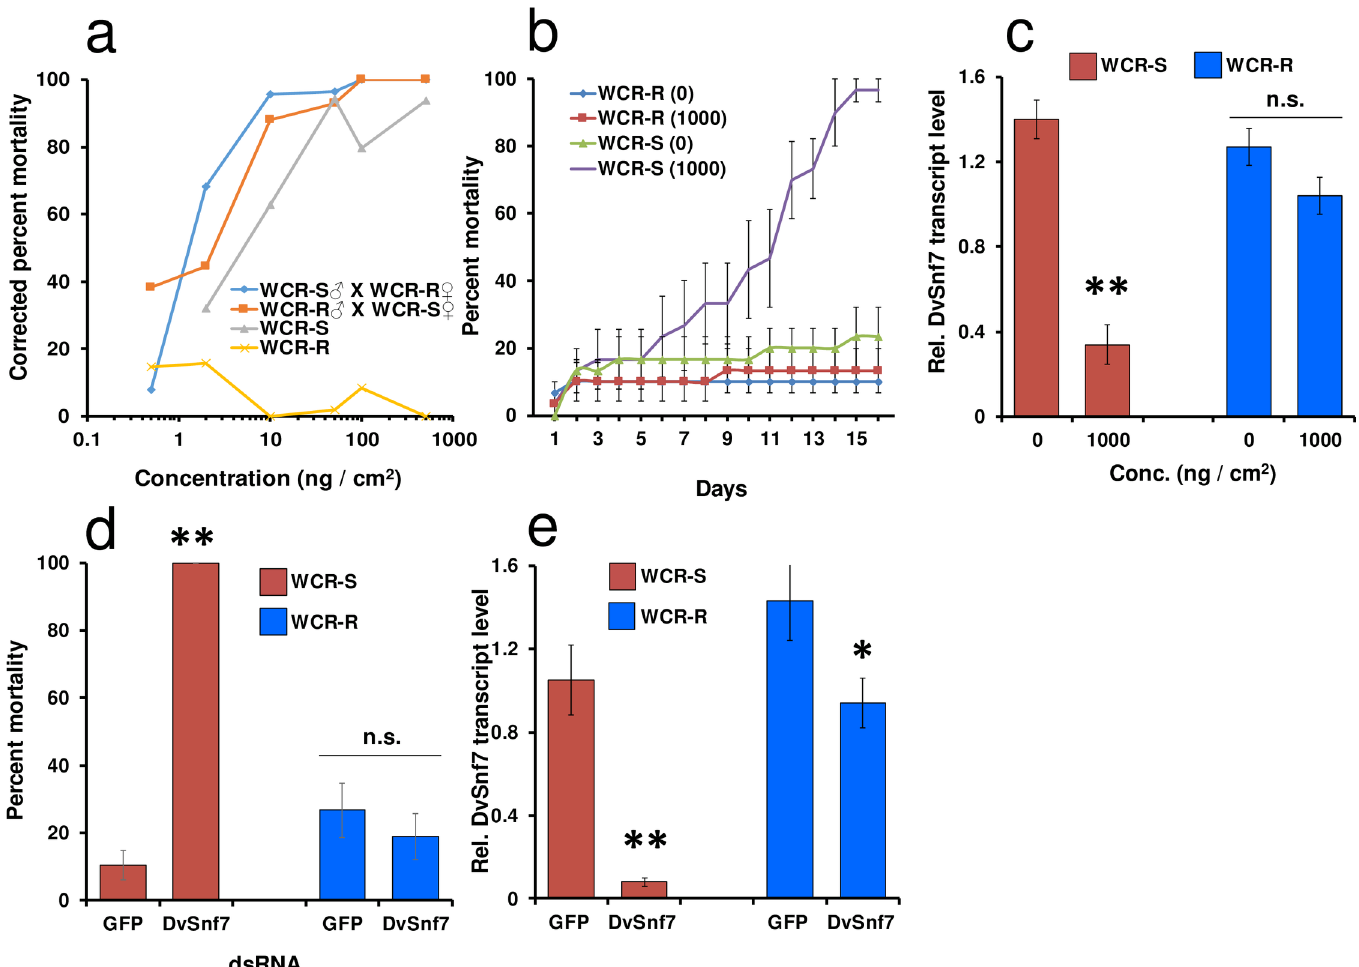
Fig 2. WCR-R larvae and beetles are resistant to DvSnf7 dsRNA and inheritance of DvSnf7 dsRNA resistance is recessive. ( a ) Concentration–response curves of WCR-S, WCR-R neonates and F1 neonates from WCR-R and WCR-S reciprocal crosses. Each cross was bulk-mated and consisted of 80 males and 80 females. Each population was assayed using 5–6 concentrations ( n = 105–254). ( b ) Percent beetle mortality from WCR-R and WCR-S when exposed to artificial diet overlaid with DvSnf7 dsRNA (1000 ng /cm 2 ) or water (0 ng /cm 2 ). Assay was conducted one time with three replications, each consisting of 10 beetles ( n for all treatments = 30). ( c ) DvSnf7 transcript levels determined using RT-qPCR in beetles fed for 72 hrs on artificial diet overlaid with DvSnf7 dsRNA or water ( n = 7–8). ( d ) Percent beetle mortality from WCR-R and WCR-S when injected with 25 ng of either DvSnf7 or GFP dsRNA. Mortality was recorded 10 d after injection. Assay was conducted two times each with three replications ( n = 30–48). ( e ) DvSnf7 transcript levels determined using RT-qPCR in beetles injected with 25 ng of DvSnf7 or GFP dsRNA. After injections beetles were allowed to feed on untreated artificial diet for 72 h and collected for transcript analysis ( n = 3–8). (c to e) Means ± SEM. (cid:3)(cid:3) p < 0.0001, (cid:3) p = 0.042.